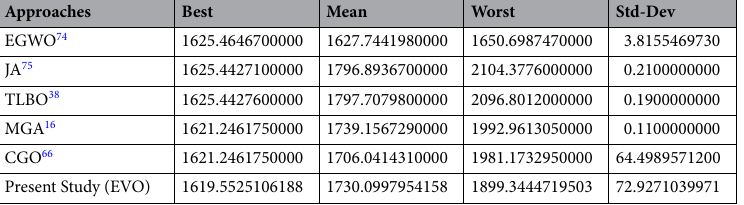
Table 11. Statistical results of different approaches for the hydro-static thrust bearing design problem. EGWO, Enhanced grey wolf optimizer; JA, Jaya